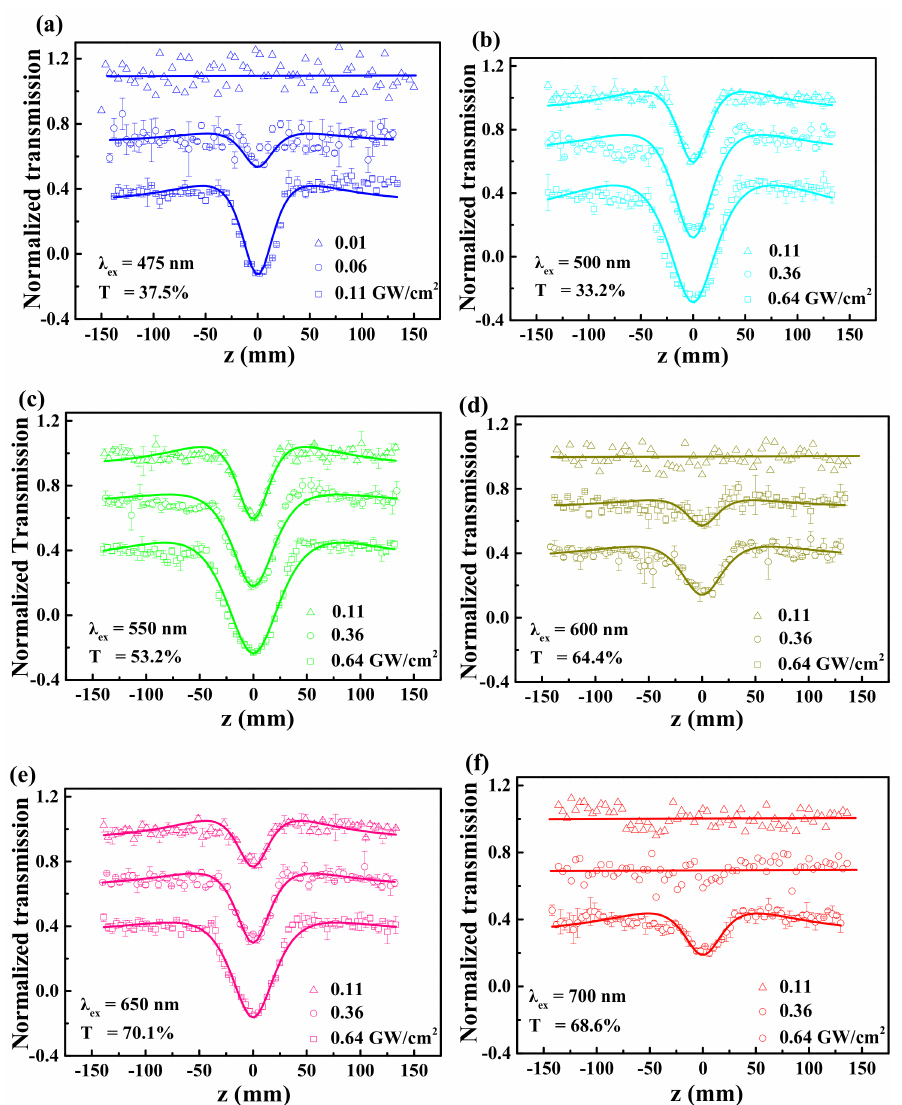
Figure 2. ( a – f ) Normalized transmission of the Ti 3 C 2 nanosheet dispersion position for a nanosecond open aperture Z-scan under di ff erent wavelengths from 475 to 700 nm in the visible region, where the solid lines are the fitting curves. The fluence changes from 0.01 to 0.64 GW / cm 2